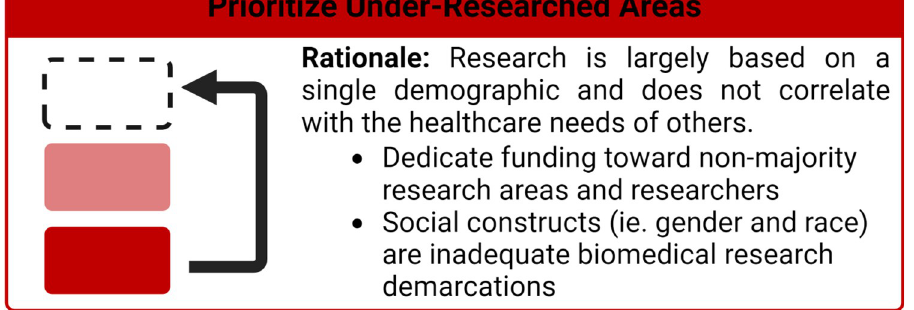
Fig 3. Rationale for prioritizing research in under investigated areas of healthcare disparities and diversifying biomedical research and takeaways from Rules 4 through 7.